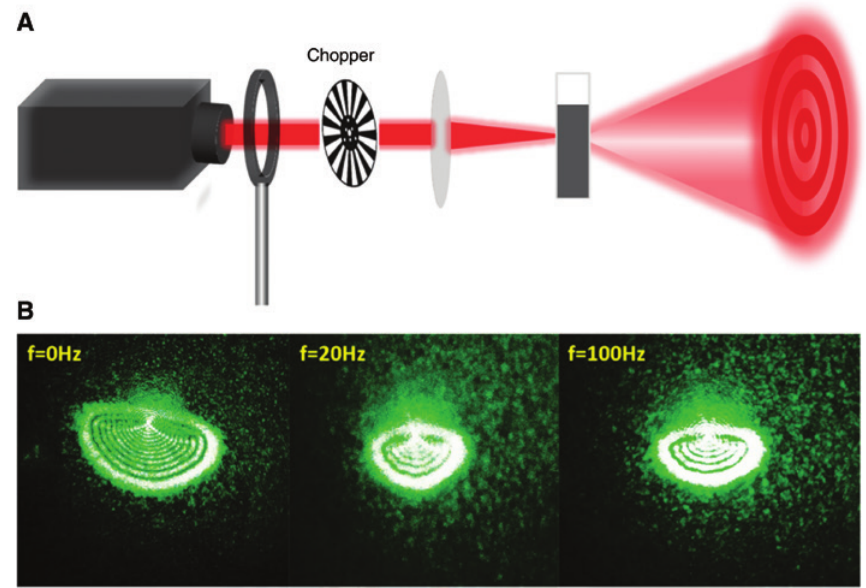
Figure 3: The contrast experiment with different incident intensity. (A) The experimental facility diagram of SSPM and (B) the diffraction ring for the modulator frequencies of f = 0 Hz, f = 20 Hz, f = 100 Hz.